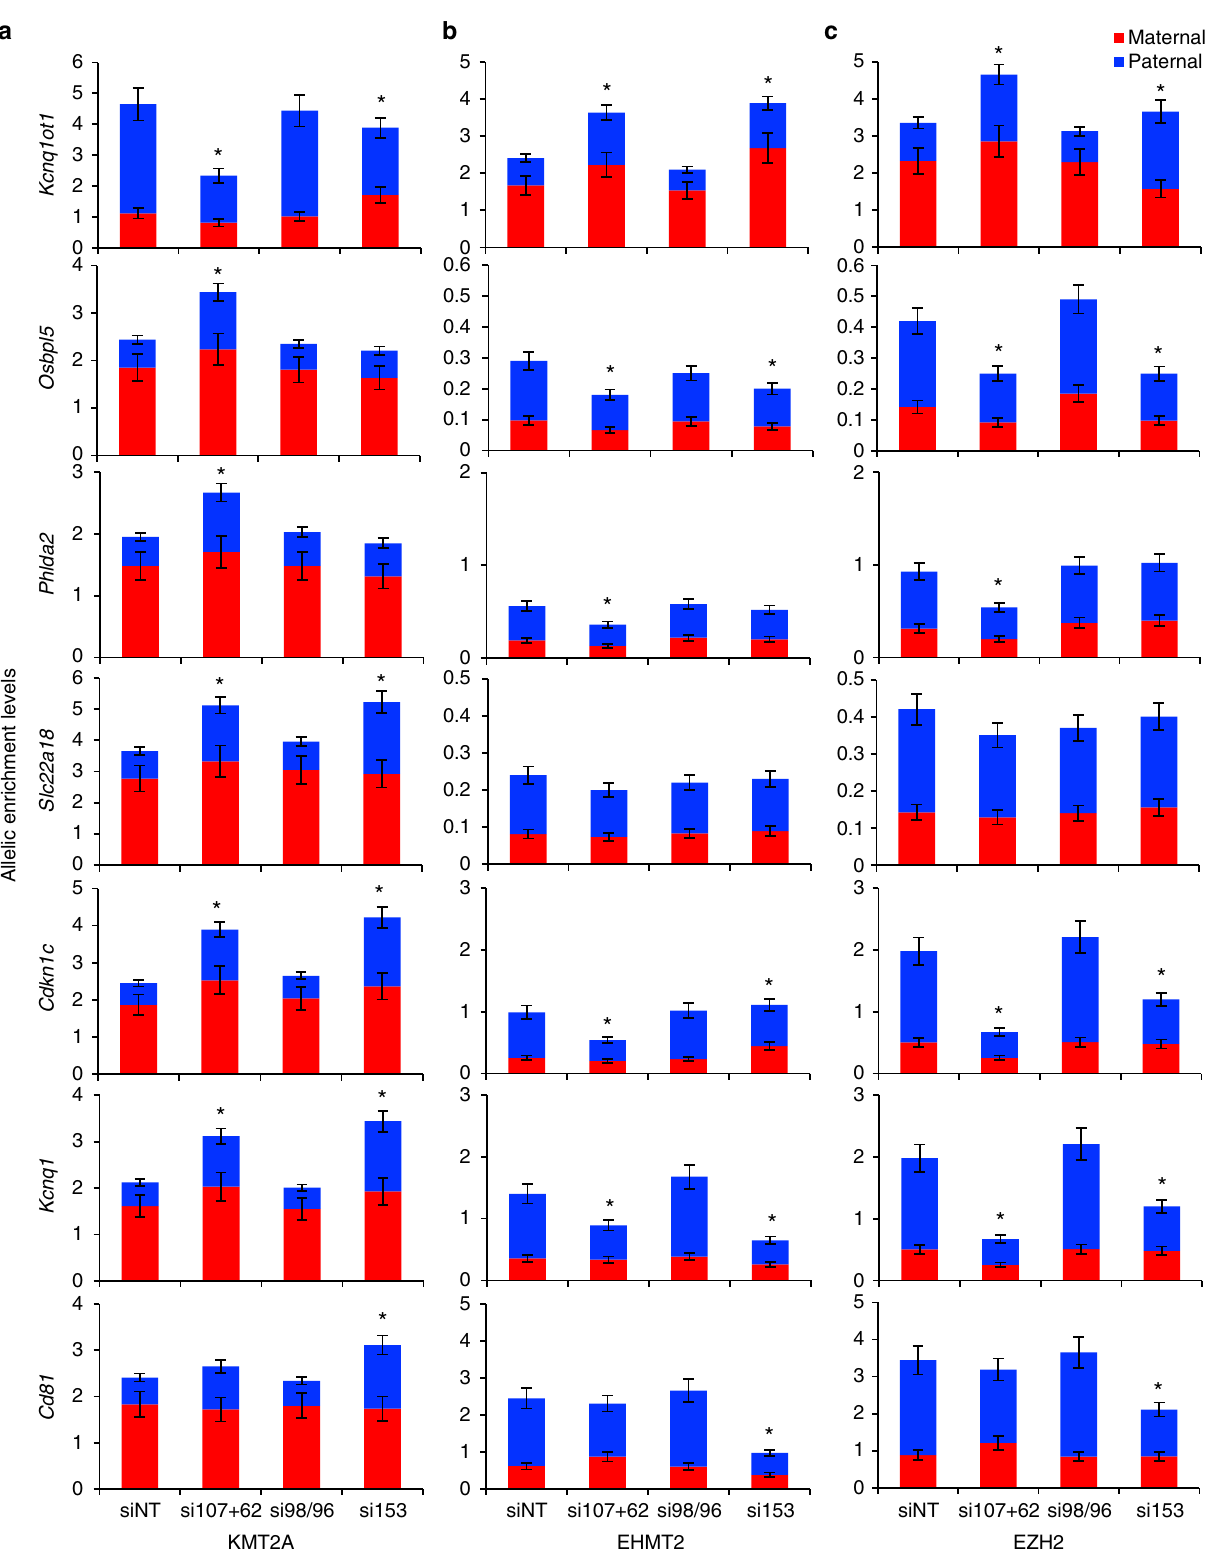
Fig. 6 Nup107, Nup62 , and Nup153 depletion disrupts KMT2A, EHMT2, and EZH2 occupancy at the Kcnq1ot1 ICR and imprinted gene promoters. a KMT2A, b EHMT2 and c EZH2 ChIP at the maternal and paternal Kcnq1ot1 ICR and imprinted gene promoters in control and Nup -depleted XEN cells ( n = 3 biological samples with three technical replicates per sample). The y -axis indicates total ChIP allelic enrichment levels represented as percent of input. Allelic proportions are represented as a percent of the total ChIP enrichment level. Error bars, s.e.m.; *, signi fi cance p < 0.05 compared to the siNT control ( t